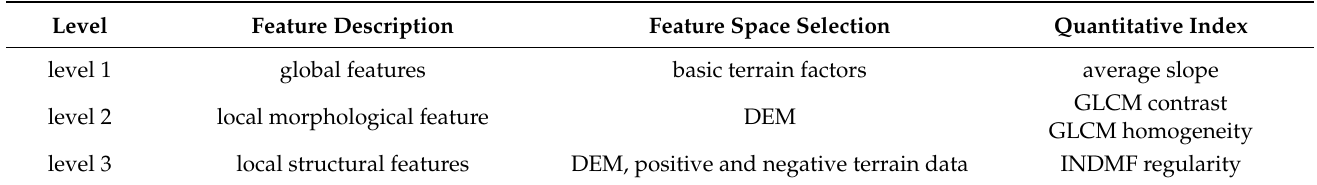
Table 2. Three-level recognition rules of typical landforms in the Loess